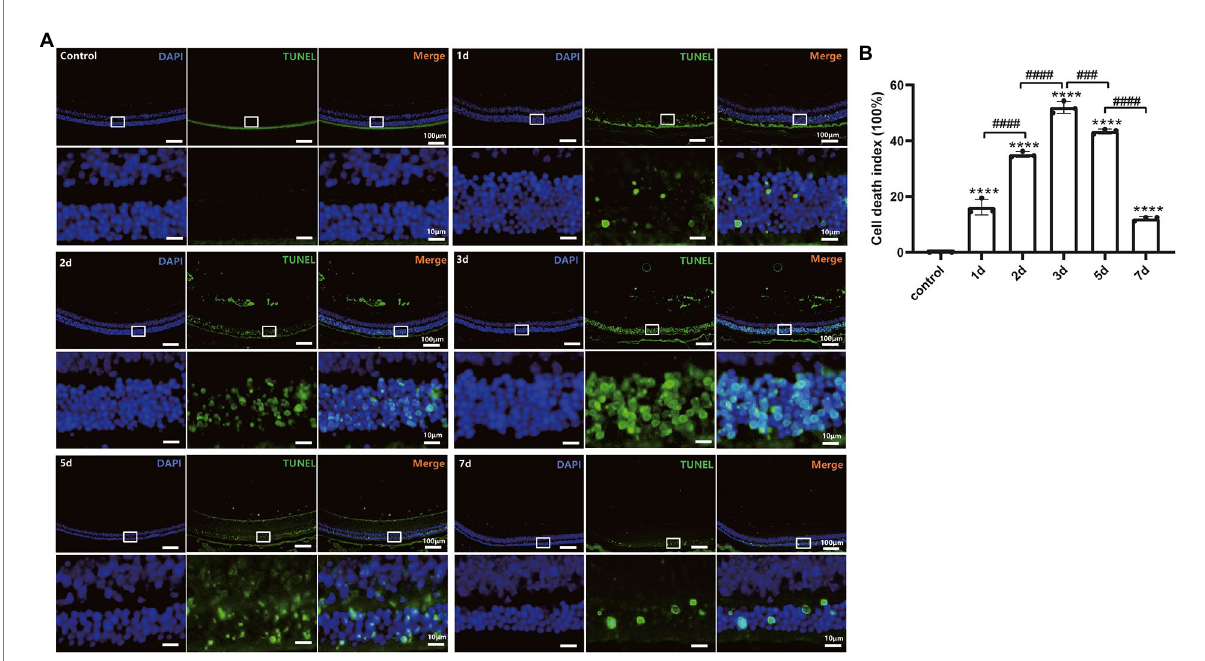
FIGURE 4 MMS-induced photoreceptor cell death labeled by TUNEL. (A) Representative retinal image for TUNEL and DAPI co-staining of control and MMS treated mice at different time points. 10×, Scale bar = 100 μ m; The zoom-in images were posted right below the originals with 10 times magnification. Scale bar = 10 μ m. (B) Quantification of cell death index in retinal sections after MMS administration at different time points. Data were expressed as mean ± SD, n = 3/group. One-way ANOVA analysis followed by Tukey’s post hoc test, **** p < 0.0001 for differences compared to controls, ### p < 0.001, #### p < 0.0001 for differences compared to previous time point